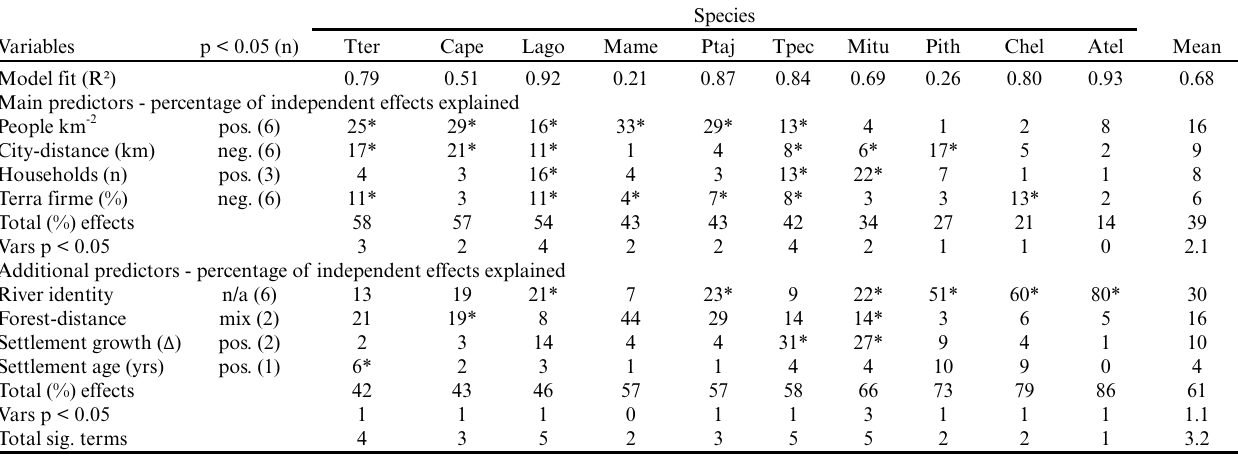
Table 1 . Results of hierarchical partitioning, an analytical procedure that was used to separate the independent explanatory effects of human settlement and landscape predictors on the depletion (estimated by nearest encounter distance) of 10 Amazonian large- vertebrates. Model fit is approximated using generalized additive models (GAM) measures and significant effects (* = p < 0.05) identified using randomizations. Species codes refer to (in order): Tapirus terrestris , Cebus apella , Lagothrix spp., Mazama americana , Pecari tajacu , Tayassu pecari , Mitu / Crax spp., Pithecia spp., Chelonoidis spp., and Ateles